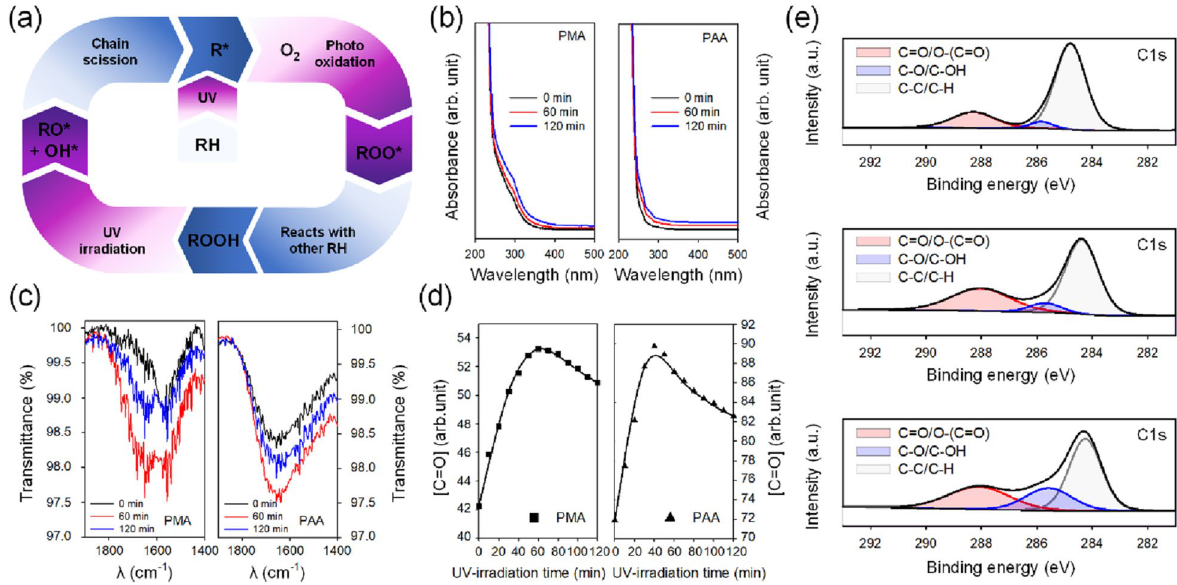
Figure 1. ( a ) General oxidation and photo-oxidation cycle of polymers. ( b ) Absorbance spectra and ( c ) FTIR spectrum of UV irradiated PMA (left) and PAA (right) by the UV irradiation time; 0, 60, and 120 min. ( d ) Changes in integral intensity of carbonyl band (1707 cm −1 ) during UV irradiation for 120 min. ( e ) XPS spectra of PAA according to UV irradiation time; (top) 0 min, (middle) 60 min, and (bottom) 120 min. The peak at 288.2 eV is a C = O bonding and the 285.8 eV peak indicates C-O bonding. The peak at 284.4 eV is corresponding to C–C and C-H of the polymer chain 47–49